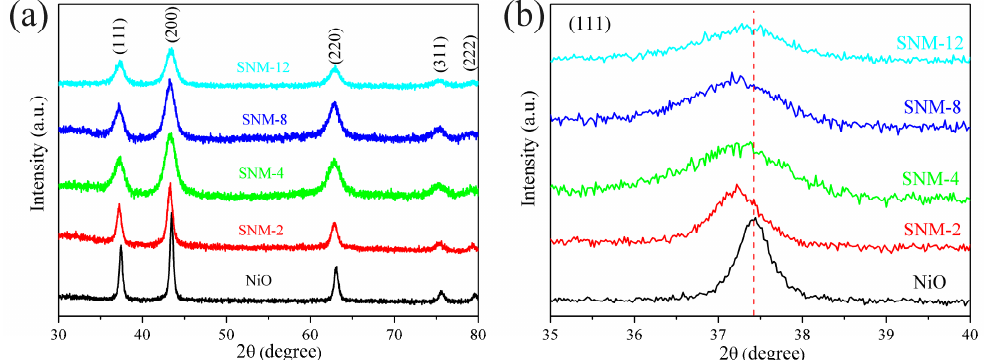
Figure 2. XRD patterns for the pure NiO and the 2, 4, 8, and 12 at% SNM, ( a ) full scale scan from 30–80 degree and ( b ) expanding pattern at (111) peak for these materials.